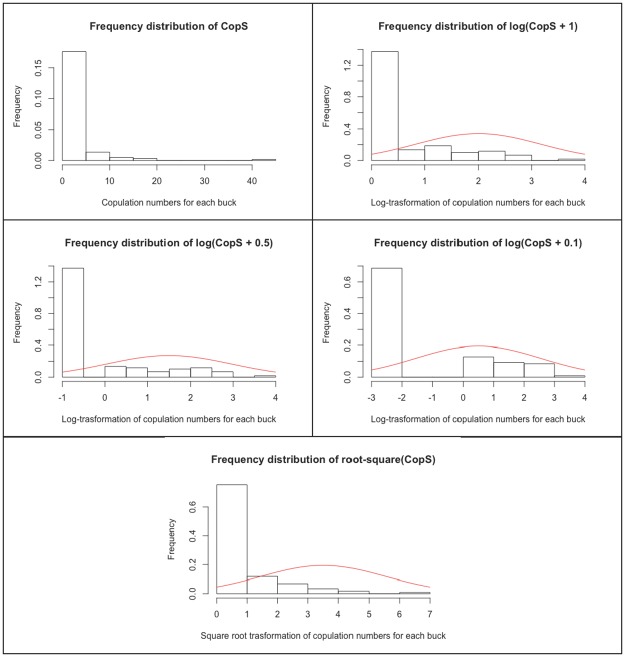
Frequency distribution of number of copulations achieved by each buck (CopS) before (upper left panel) and after transformation.The continuous red line shows the theoretical normal curve for reference.